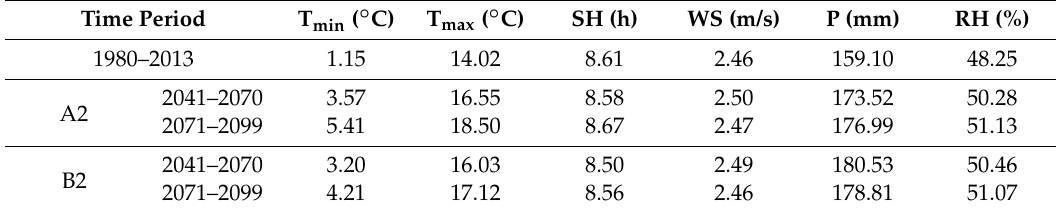
Table 2. The average value of parameters in different time